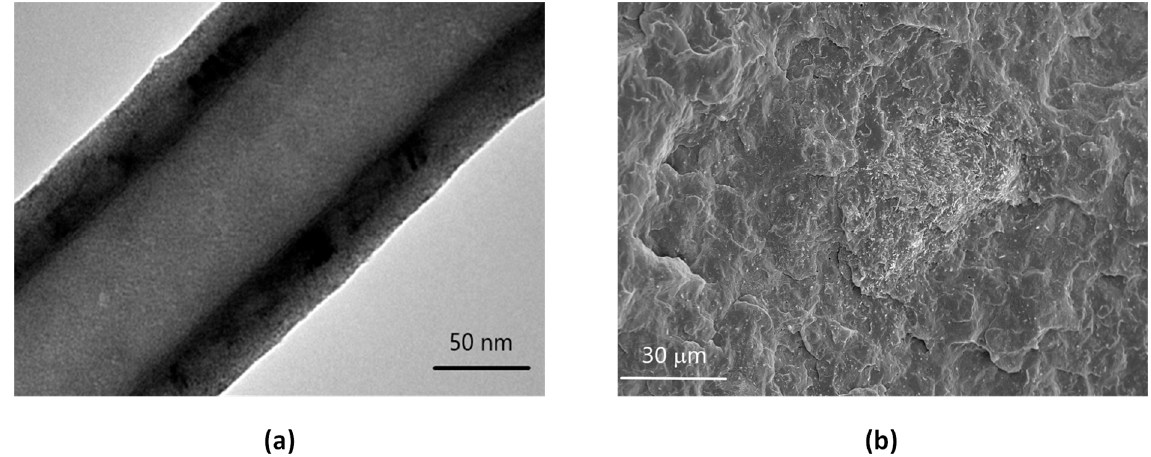
Figure 1. Pyrolytically stripped Pyrograf ® -III PR 25 PS XT carbon nanofiber and melt-mixed PP/CNF composites. TEM micrograph of CNF ( a ) and SEM micrograph of PP/CNF 2 wt. % composites ( b ).